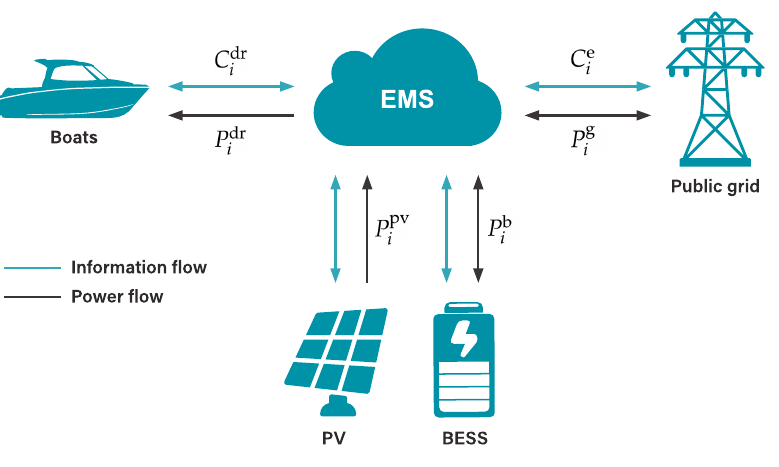
Figure 6. Marina’s energy management